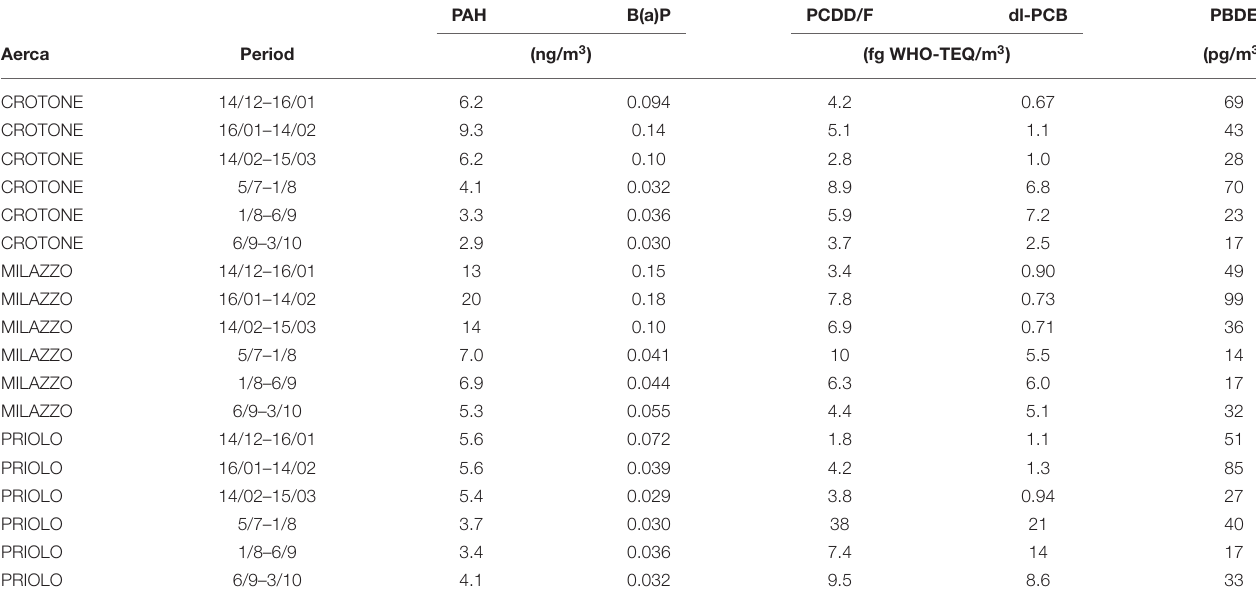
TABLE 3 | Air concentration of micro-organics at the three AERCAs during the study period. PAH B(a)P PCDD/F dl-PCB PBDE Aerca Period (ng/m 3 ) (fg WHO-TEQ/m 3 ) (pg/m 3 )